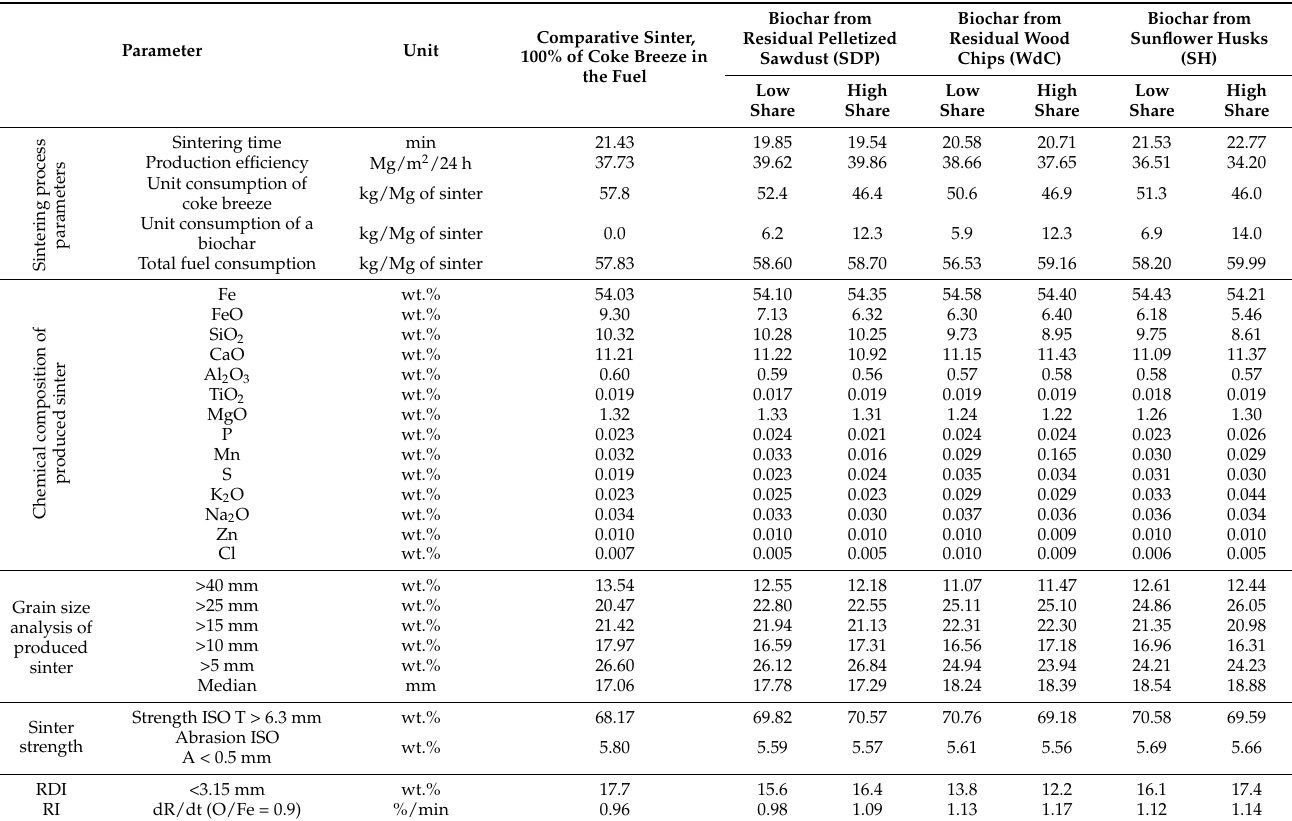
Table 6. The results of the laboratory sintering tests with low and high share of biochar in fuel.